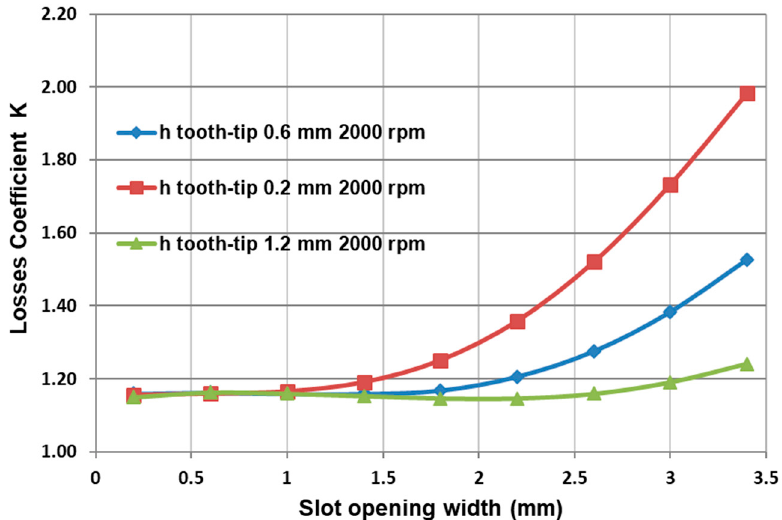
Figure 33. h tooth-tip and slot opening width effect on K .